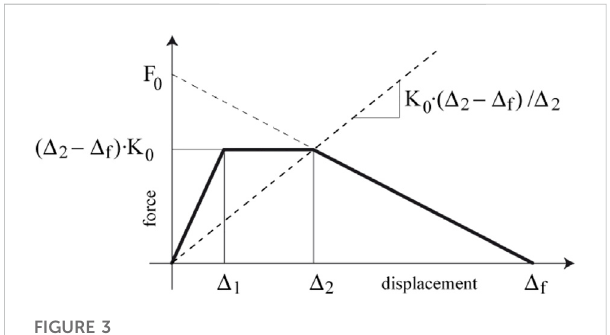
FIGURE 3 The natural frequency is determined considering a secant stiffness (Doherty et al., 2002).